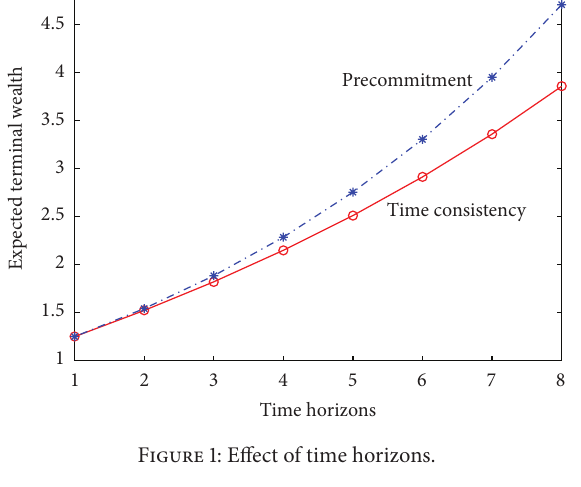
Figure 1: Effect of time horizons.